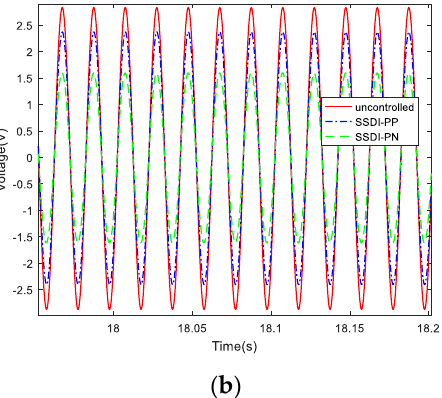
Figure 27. Displacement comparison curves in three cases (50 Hz): ( a ) displacement comparison curves; ( b ) displacement comparison curves (zoom-in).